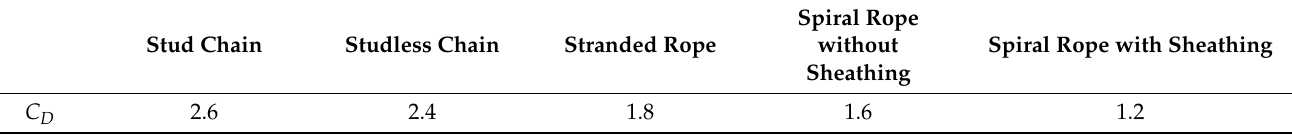
Table 11. DNV’s applicable drag coefficient ( C D ) for chain and